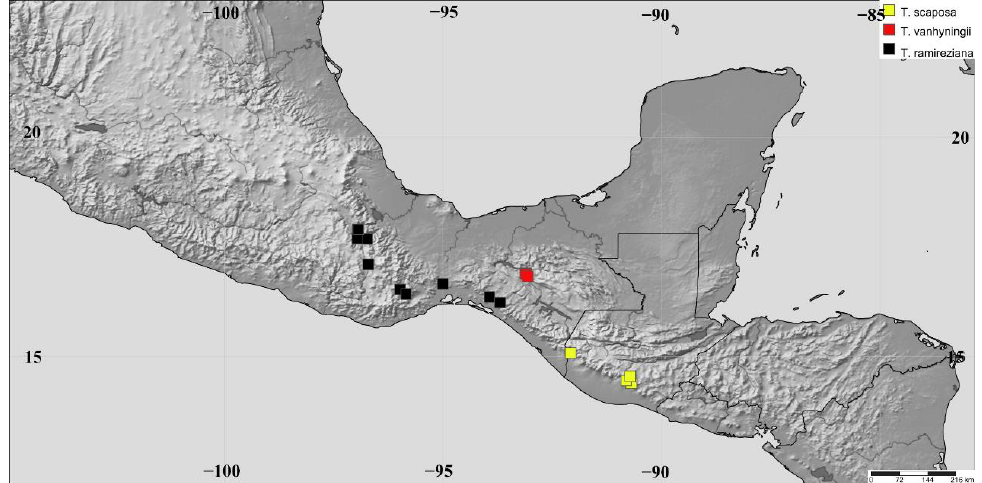
Figure 7. Geographical distribution of Tillandsia ramireziana (black squares), Tillandsia scaposa (yellow squares) and Tillandsia vanhyningii (red squares).